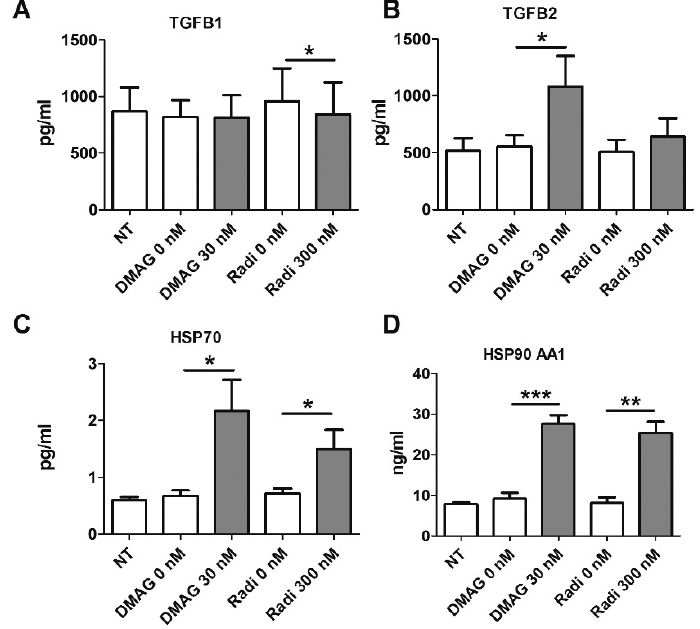
Figure 4. Multiplex bead assay to measure TGF β and HSP protein levels in CAF following HSP inhibitor treatment. CAF were treated with Radicicol or 17-DMAG and conditioned medium was assayed for secreted TGF β 1 ( A ) and TGF β 2 ( B ); TGF β 1 levels remained the same or were slightly decreased by radicicol treatment, while TGF β 2 secretion increased upon treatment with 17-DMAG. Intracellular levels of HSP70 ( C ) and HSP90 AA1 ( D ) were measured in CAF cell lysates. Increased levels of both HSP70 and HSP90 AA1 were observed after treatment with both, 17-DMAG and radicicol ( n = 4 different CAF lines measured in duplicates; paired, one-sided t -tests). All panels: mean + S.E.M. and asterisks denote the level of significance as mentioned above.